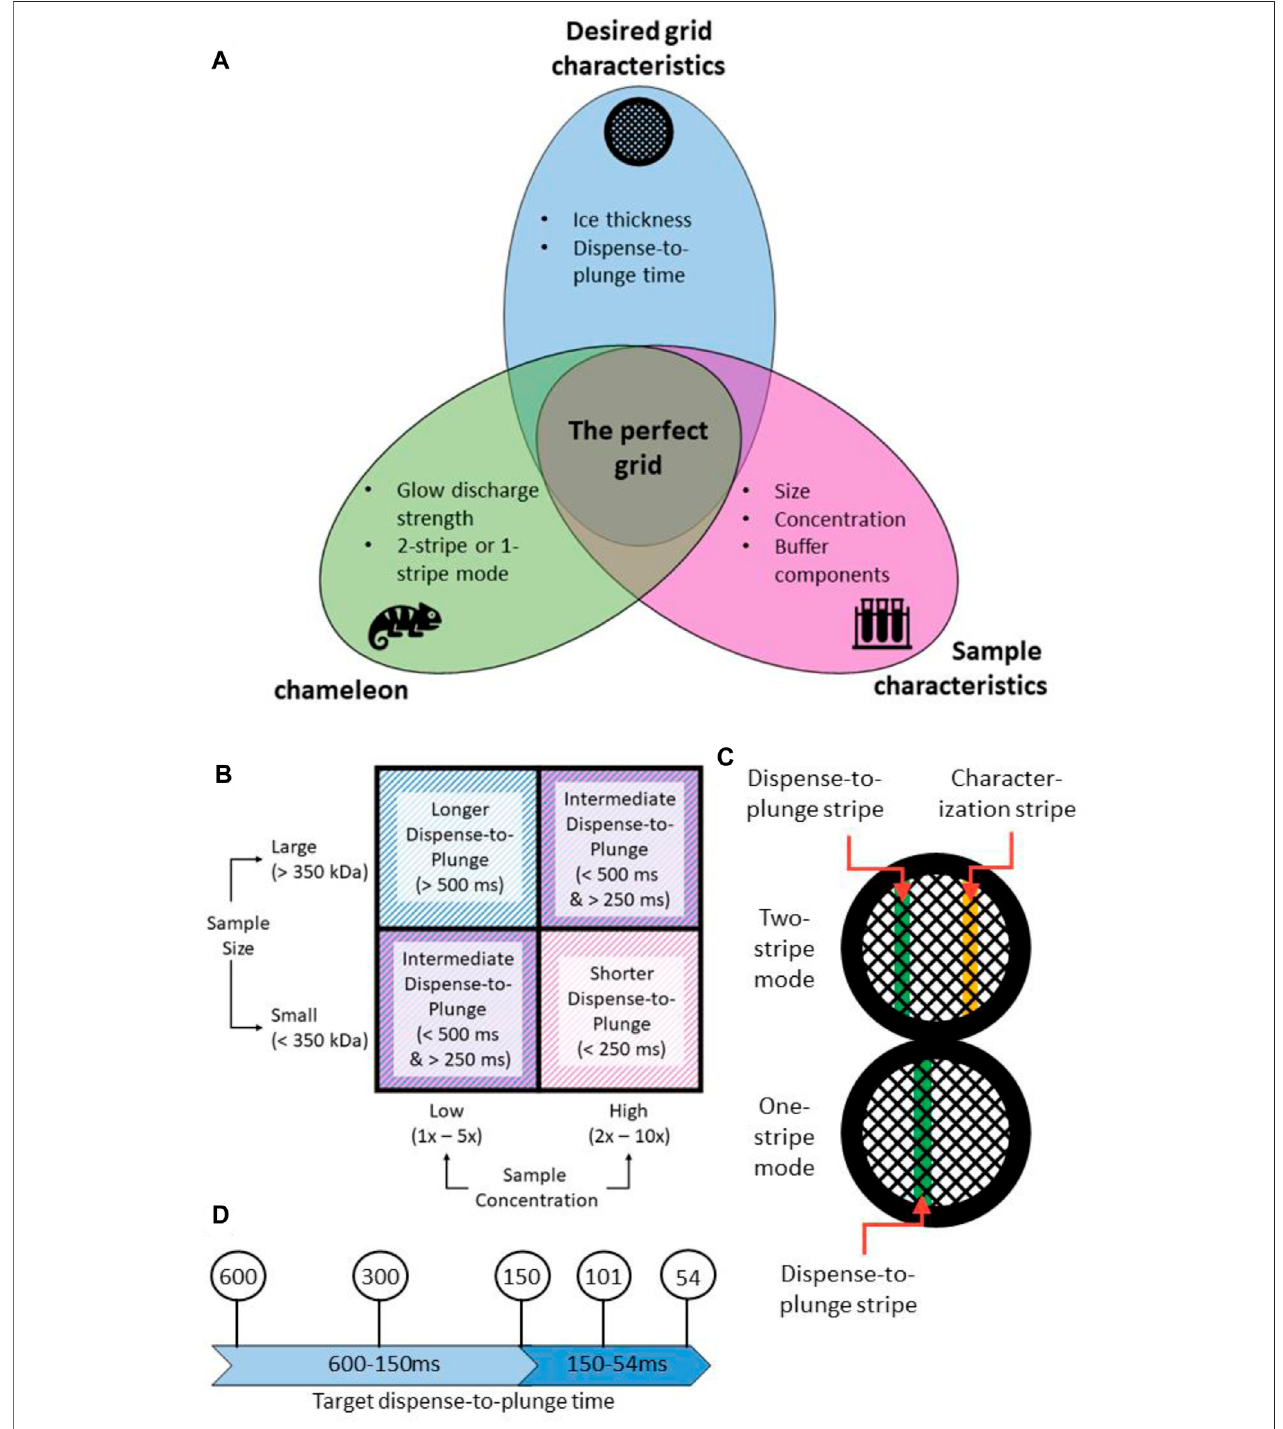
FIGURE 6 | A strategy for approaching chameleon specimen preparation. (A) Creation of the “ perfect grid ” relies on the relationship between the input sample characteristics, the settings used on the chameleon system, and the desired output grid characteristics. (B) Sample characteristics such as concentration and size can affecttherangeofdispense-to-plunge timesthatareachievable.Shorter dispense-to-plungetimesgenerallyrequireahigher concentration ofsample,thoughthiseffect is also modulated by the sample size. (C) The chameleon system has two modes for grid preparation: one-stripe and two-stripe. In two-stripe mode, a characterization stripe is fi rst applied to determine the ideal wicking time. The second, plunge stripe, is then deposited on a different part of the grid. In one-stripe mode, only one stripe is applied before plunge freezing. (D) Any target dispense-to-plunge time can be achieved by adjusting various parameters on the chameleon system. Because of the relationship between dispense-to-plunge time and specimen concentration observed on the grid (see Supplementary Case Study S1 ), a range of dispense-to-plunge times should be assessed.